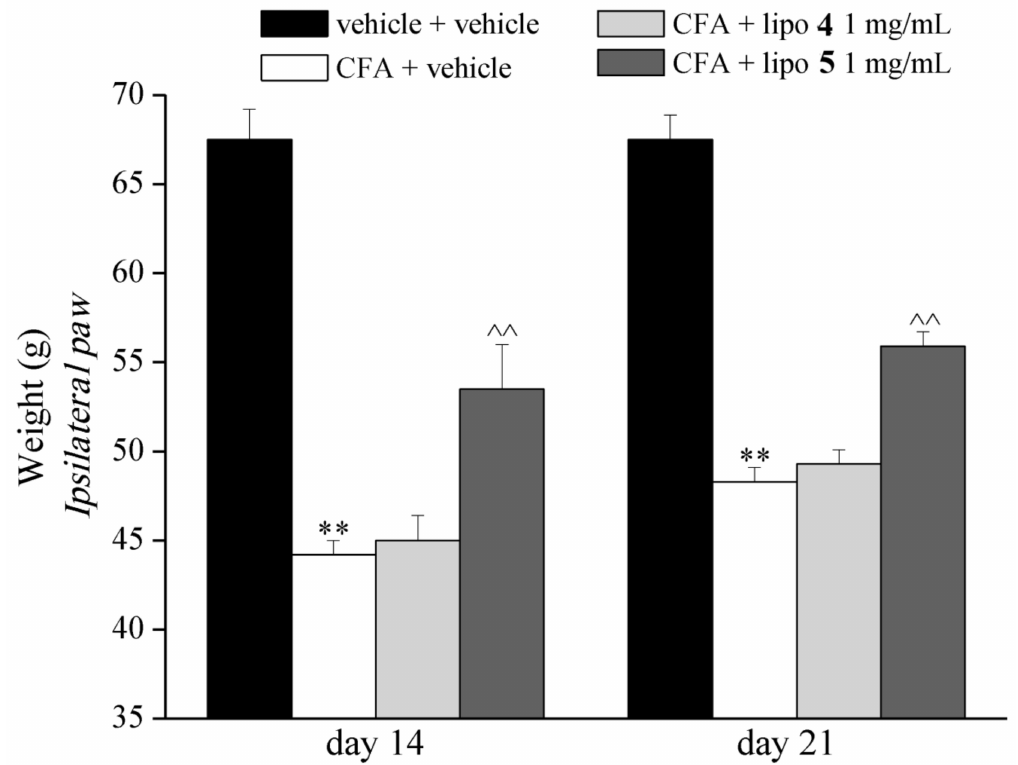
Figure 4. Intra-articular pain reliever e ff ect of lipo 4 and lipo 5 in a CFA i.a. injection-induced RA model in rats. Paw pressure test was used to assess the hypersensitivity toward noxious mechanical stimulus. Fifty µ L of lipo 4 and lipo 5 (both 1 mg mL − 1 ) were i.a. injected seven days after CFA. Measurements were performed on day 14 and 21. The control animals were treated with vehicle. The value represent the mean of eight rats performed in two di ff erent experimental sets. ** p < 0.01 vs. vehicle + vehicle-treated animals; ˆ p < 0.05 and ˆˆ p < 0.01 vs. CFA + vehicle-treated animals. Lipo 4 was ine ff ective. Similar results were obtained measuring the response to a non-noxious mechanical stimulus with the von Frey test (Figure